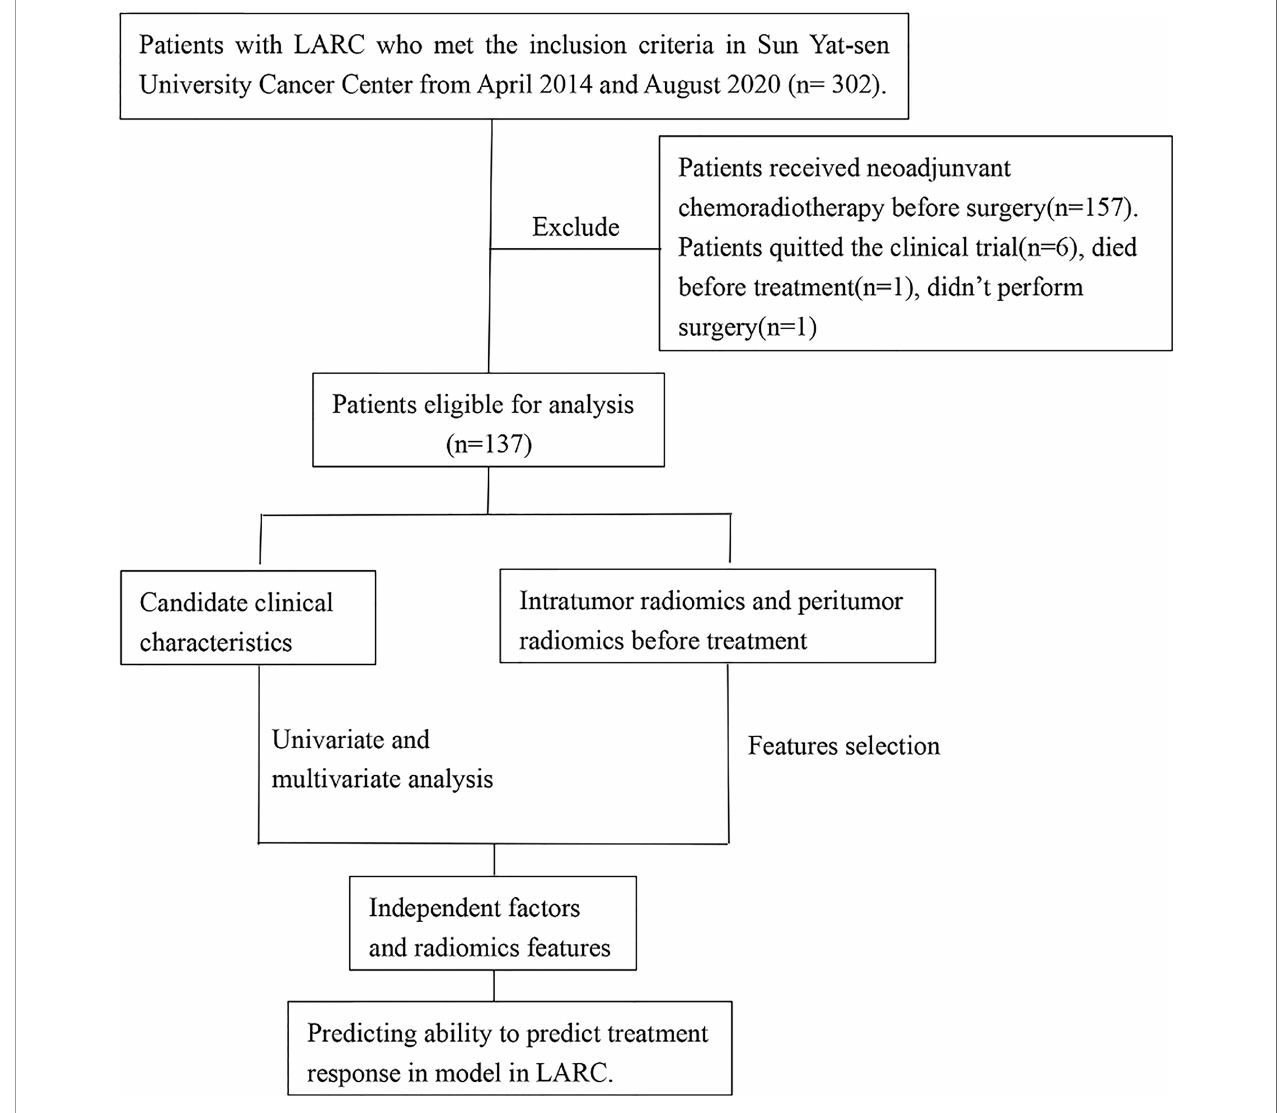
FIGURE 1 | Flow chart of the